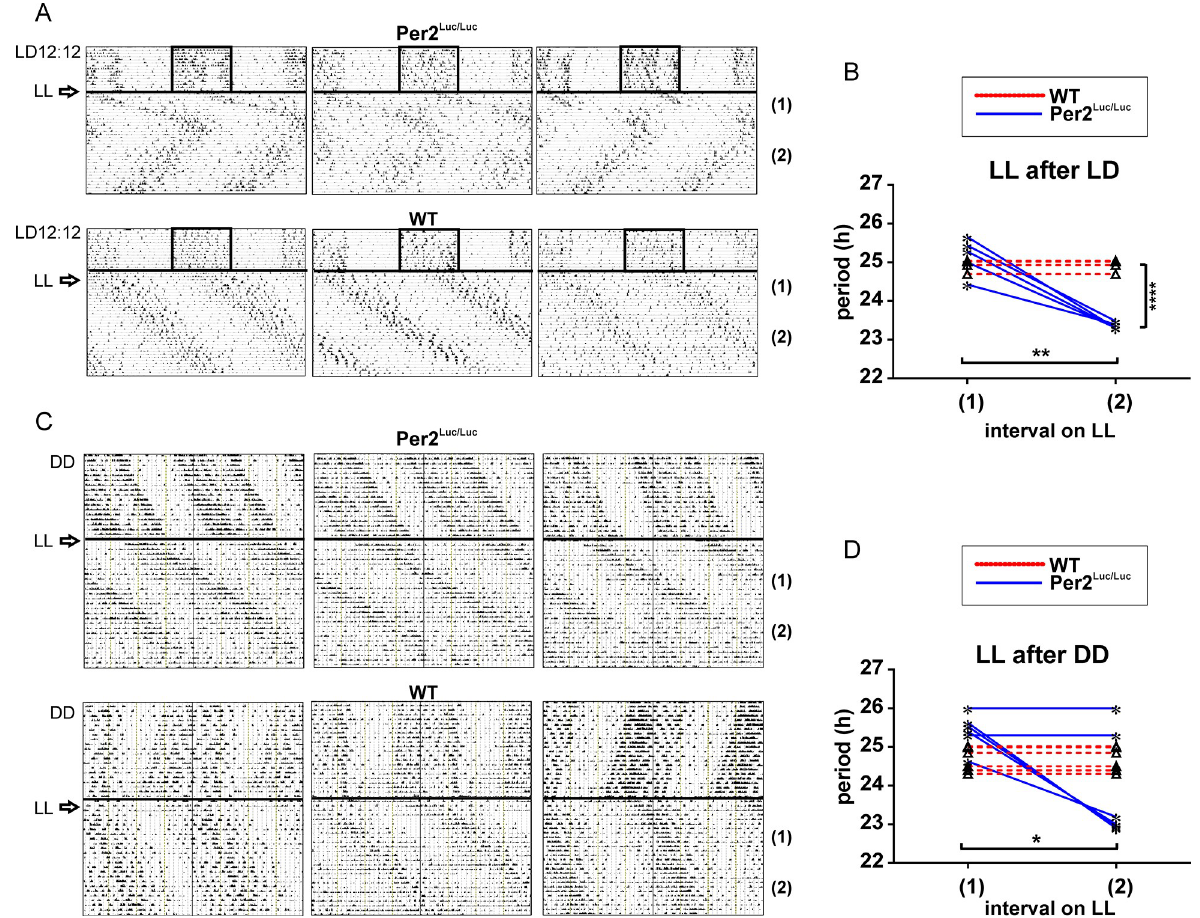
Fig 3. Genotype differences in OFA rhythms under LL following LD entrainment or DD exposure. A . Representative records of mPer2 Luc/Luc and WT control animals in LL following pre-exposure to LD12:12. B . Changes in periods of locomotor activity rhythm under LL exposure after entrainment to LD12:12. Periods were assessed in LL during the initial (1) and late (2) intervals (after 10 days in LL). mPer2 Luc/Luc mice show a long period ( > 24 h) for the initial interval (1) in LL, which spontaneously switches to a short period ( < 24 h) during the late recording interval (2), whereas WT mice exhibit the long period throughout the experiment. C. Representative records of WT C57Bl6 control animals and mPer2 Luc/Luc in LL following free-running in DD. D. Changes in periods of locomotor activity rhythm under LL after exposure to DD. Periods were assessed in LL during the initial (1) and late (2) intervals (after 2–3 weeks in LL). Periods in LL after pre-exposure to DD are long ( > 24 h) for both genotypes during the initial recording interval (1). During the late recording interval (2), the periods in some of mPer2 Luc/Luc mice spontaneously switch to a short period ( < 24 h) but retain long throughout the recording in all WT mice. � = P < .05; �� = P < .01; ���� = P < .0001.